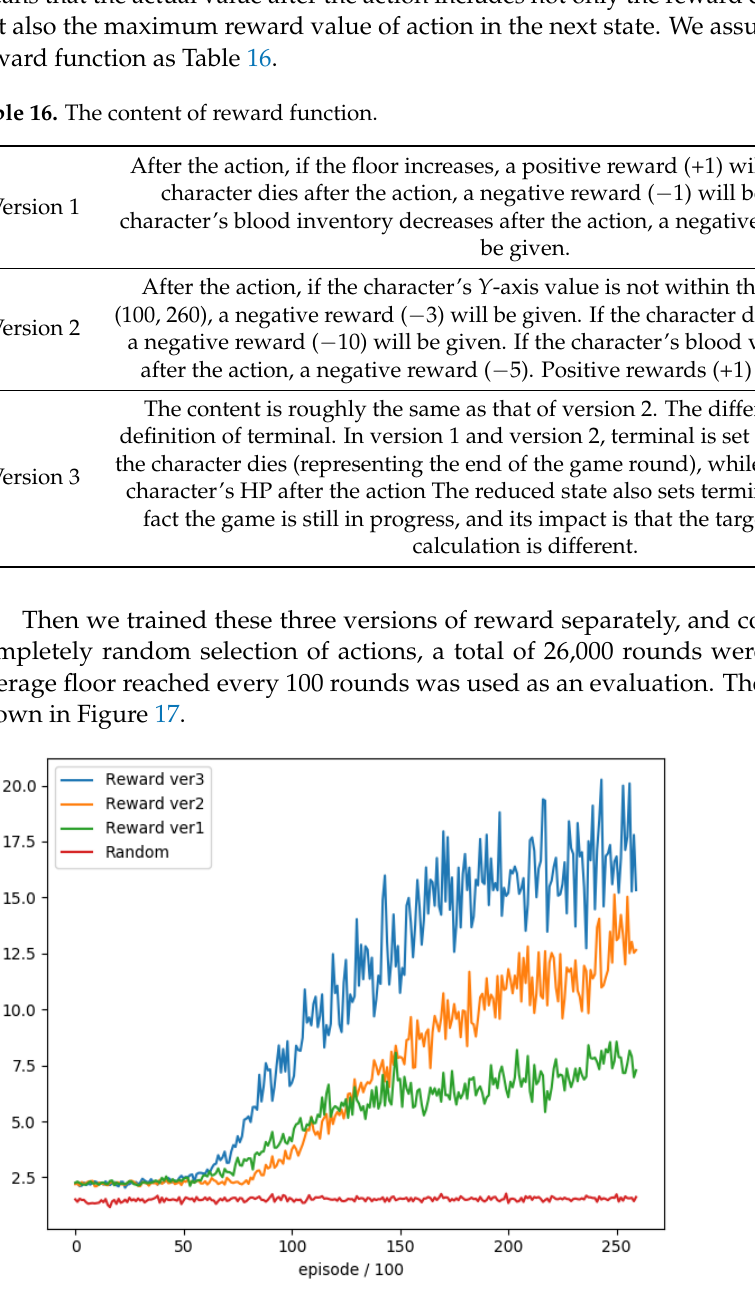
Table 16. The content of reward function.